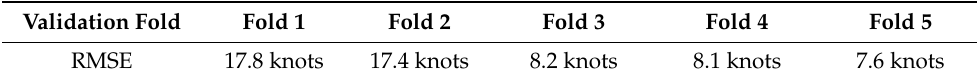
Figure 12. Absolute errors of different hurricane categories.